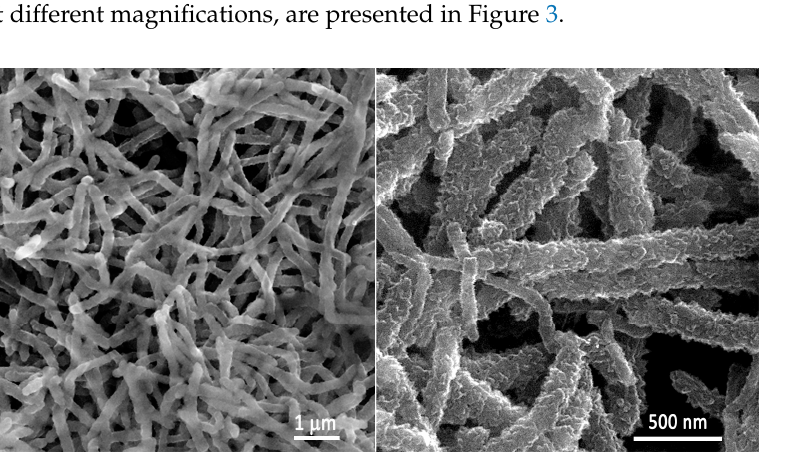
Figure 3. Scanning electron micrographs of an electrochemically formed PANI electrode at different magnifications, as marked in the figure.